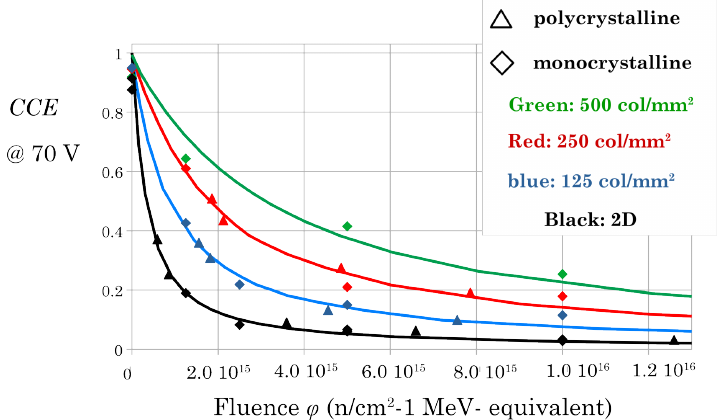
Figure 7. Experimental data fitted by the calculated CCE curves with a unique damage factor k .